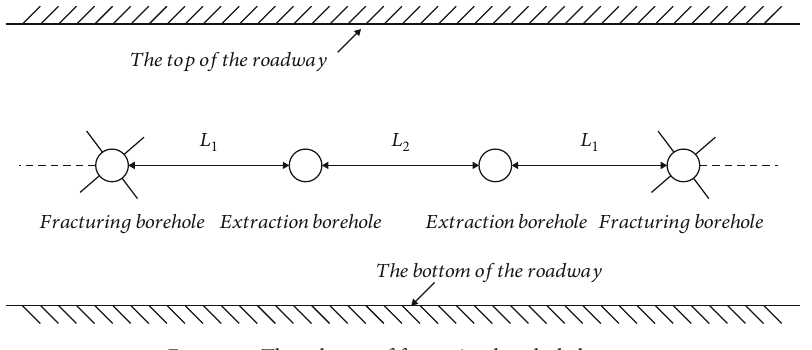
Figure 5: The scheme of fracturing borehole layout. Table 1: Main parameters of gas extraction